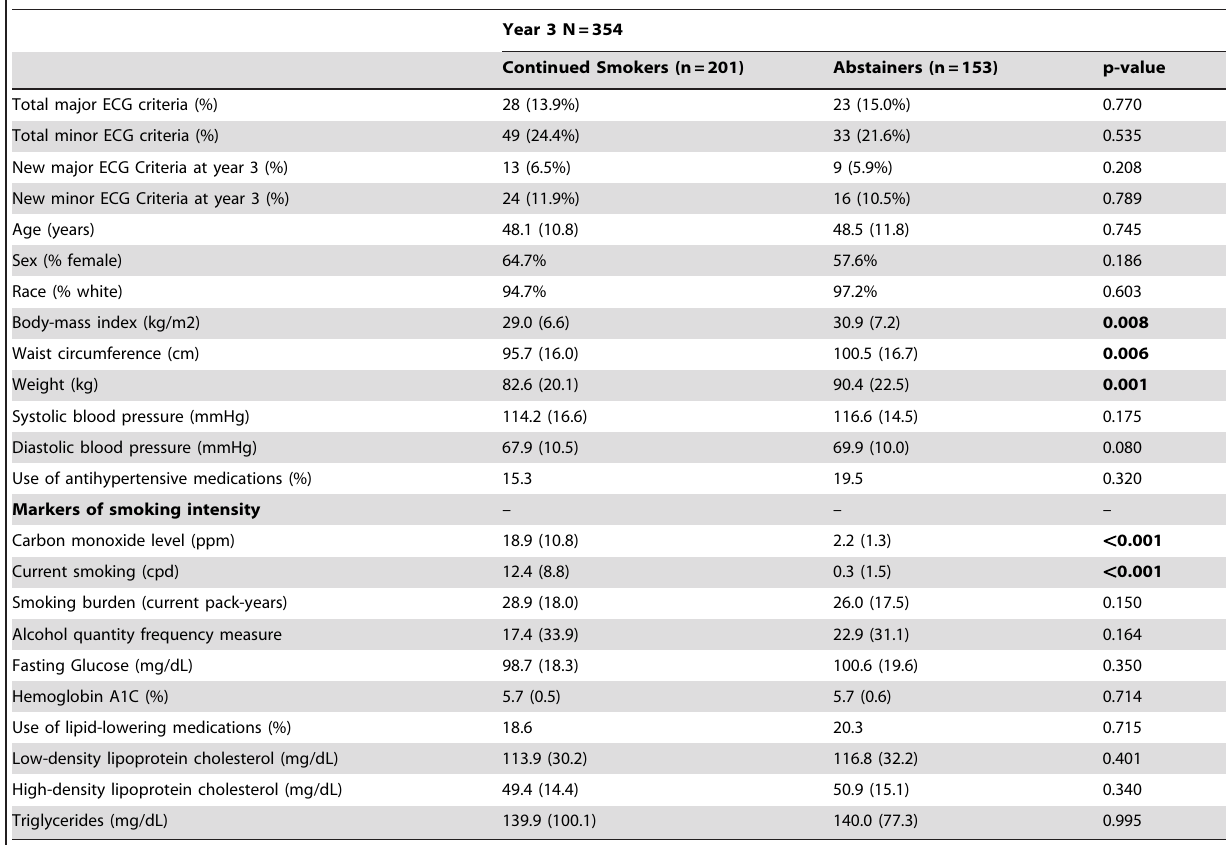
Table 2. Comparison of Continuing Smokers and Abstainers at year